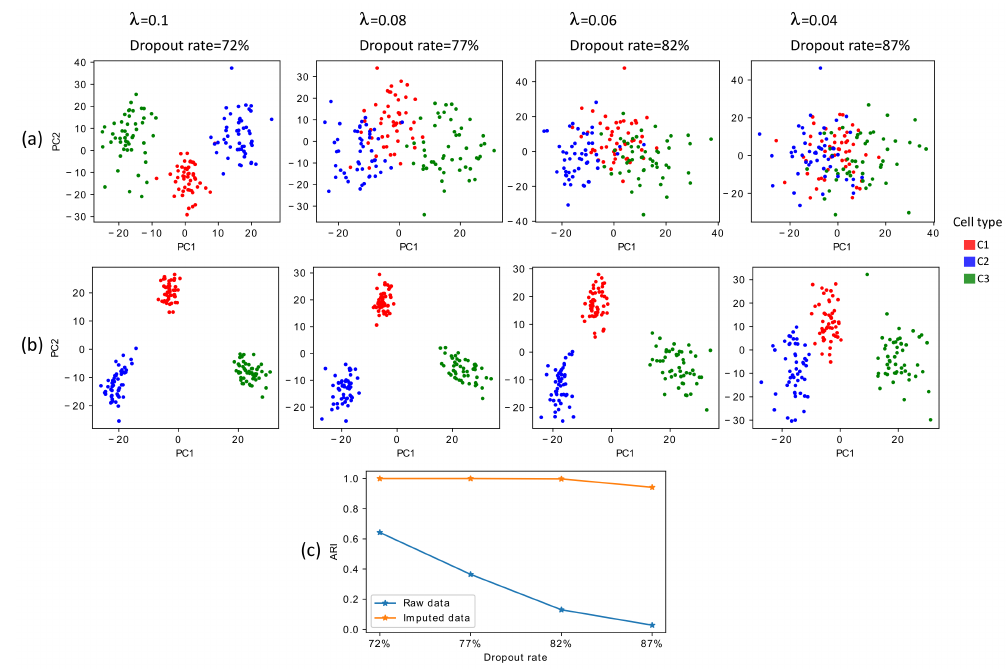
Figure 1. (Color online) netImpute improves data visualization and clustering performance on simulated data. ( a ) The first two dimensions calculated from the raw datasets with different dropout rate; ( b ) the first two PCs calculated from imputed datasets by netImpute; ( c ) clustering accuracy for both raw and imputed datasets using PCA+kmeans clustering